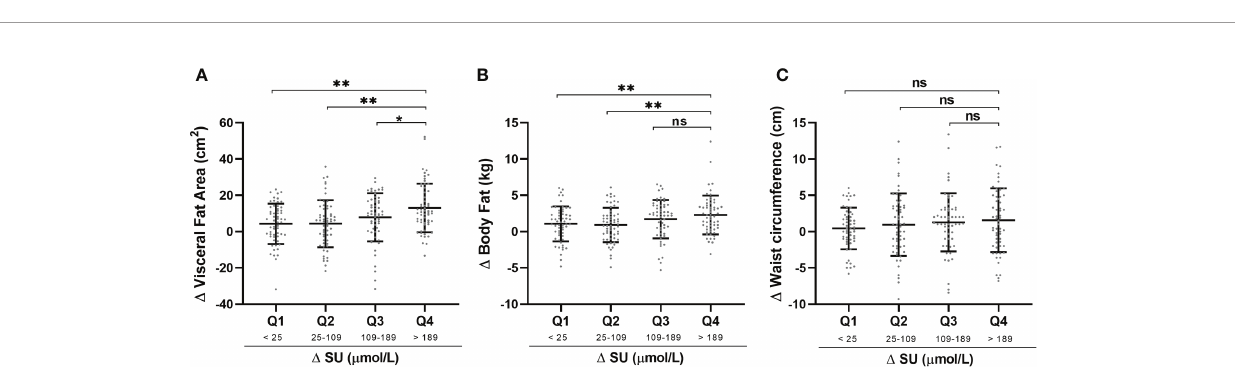
FIGURE 3 | Comparisons of characteristics with D SU quartile strati fi cation. Changes ( D ) in Visceral fat area (A) , body fat (B) and waist circumference (C) was calculated by baseline level-after treatment level and presented with Mean ± SD. Changes in SU was divided into quartiles with the following values: Q1: <25 m mol/L; Q2: 25-109 m mol/L; Q3: 109-189 m mol/L; Q4: >189 m mol/L. * P < 0.05, ** P < 0.01, ns., no signi fi cance. SU, serum